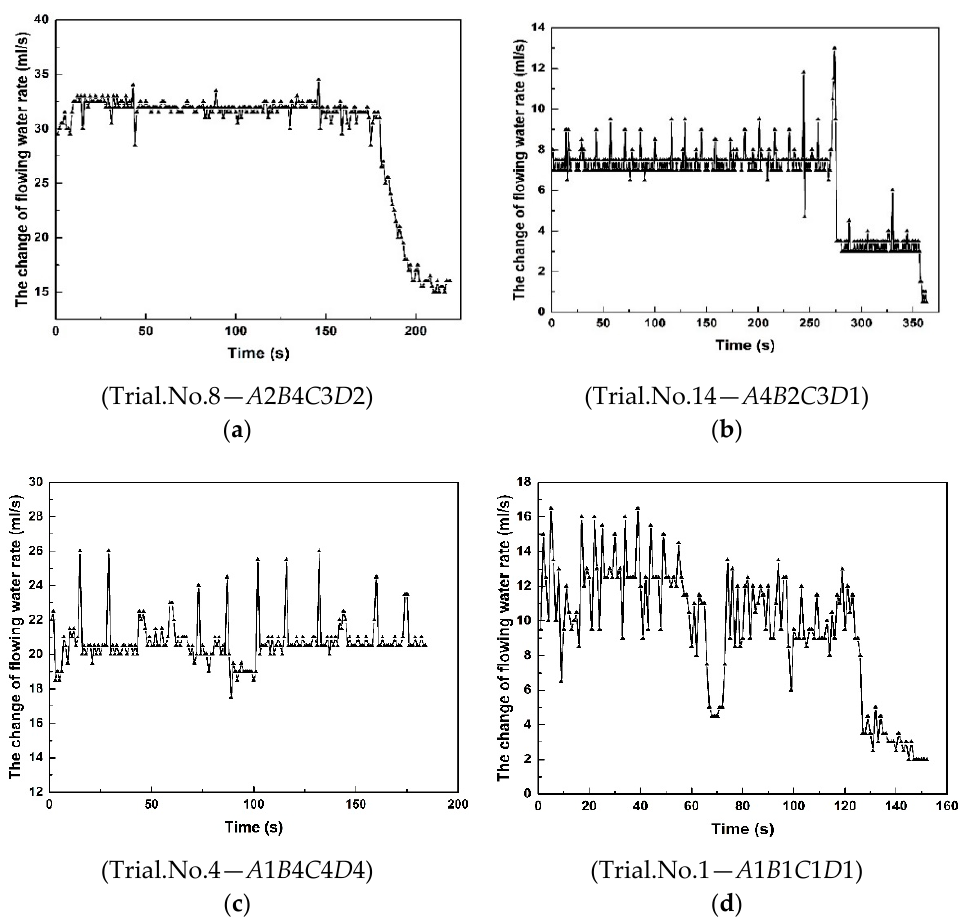
Figure 10. The change curves of flowing water. ( a ) Single platform decreasing type. ( b ) Double platform decreasing type. ( c ) Multi-peak fluctuating type. ( d ) Multi-peak fluctuating type.